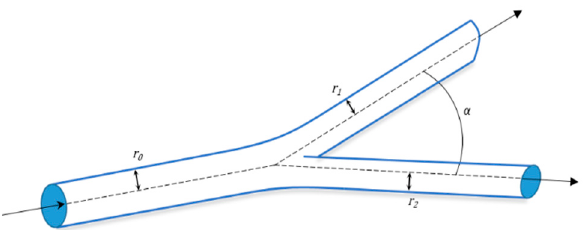
Figure 13. Schematic representation of a vascular bifurcation where r 0 , r 1 , and r 2 are the radii of the mother and daughter vessels, respectively, and α is the angle between the two daughter vessels.